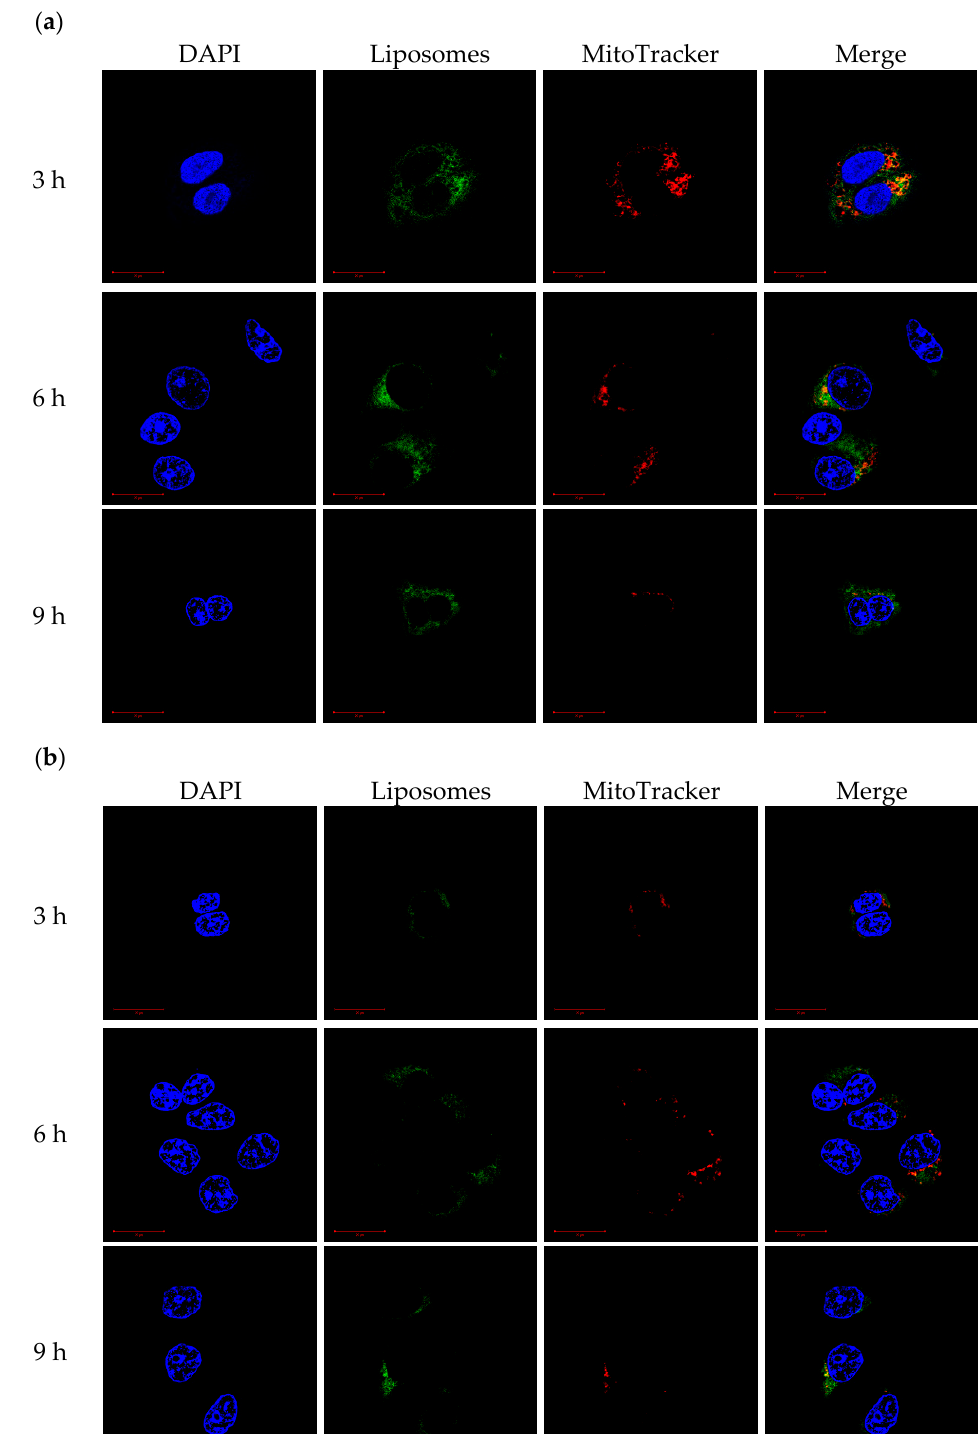
Figure 7. Endosomal escape of polymer–liposome complexes. Confocal images of ( a ) PCLH and ( b ) PCLM after co-incubation with MCF-7 cells for 3, 6, and 9 h. Scale bar: 20 μ m ( n = 3, showing one of the measurements from the data). 2.3. Mitochondrial-Targeting and Cytotoxicity of Polymer–Liposome Complexes CLSM was used to monitor the mitochondrial-targeting ability of PCLH and PCLM. Can- cer cell mitochondria and cationic liposomes were labeled with MitoTracker and FITC, respec- tively. For PCLH (Figure 8a), the intensities of FITC and MitoTracker were merged together